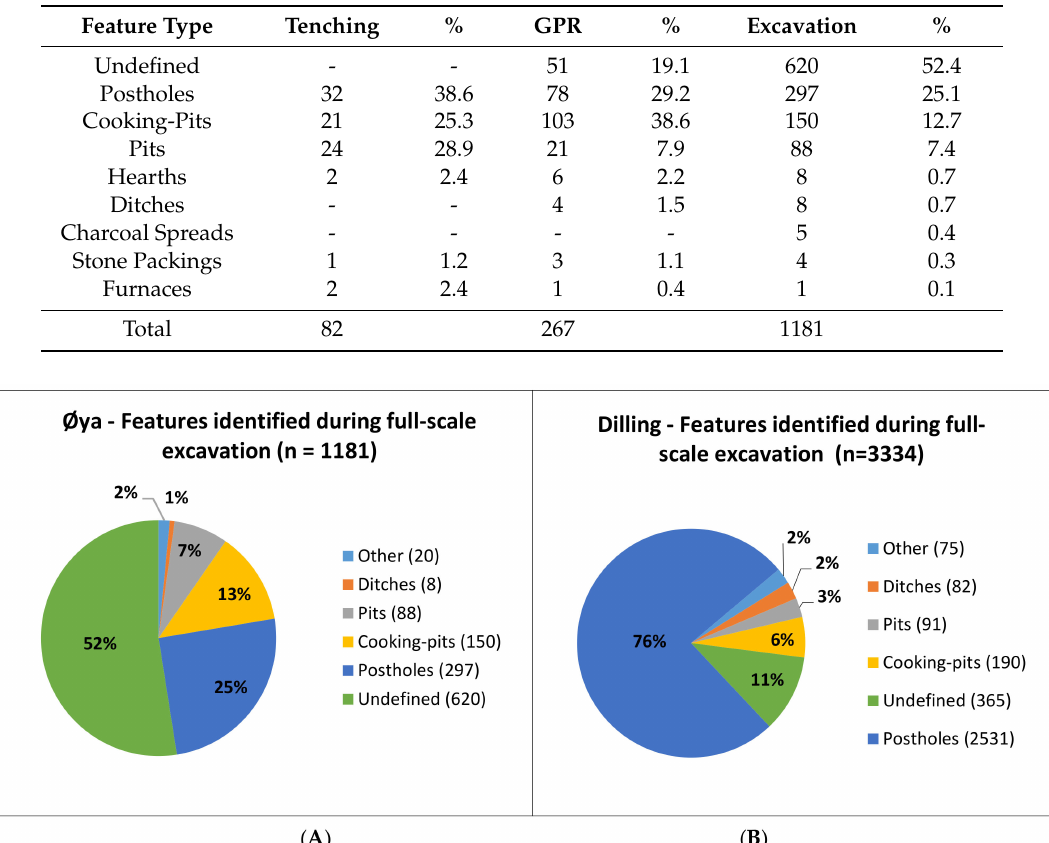
Table 2. Features identified during trial trenching, GPR surveys and excavation at Øya. Buried cultivation layers were identified during test trenching but have been removed from this table as they are not classifiable as dug features. Note that these are the features identified in the GPR data that lie within the area covered by the full-scale excavation.